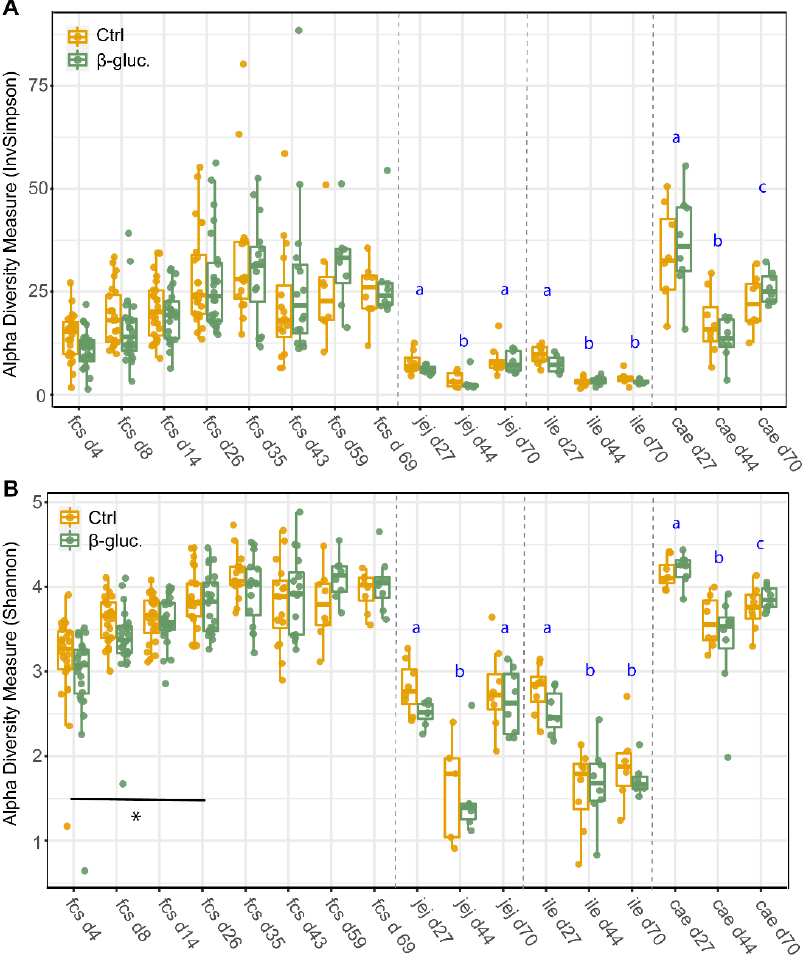
Figure 2. Alpha-diversity of faecal and luminal microbiota between treatments and over time. Every dot represents a single animal with the control animals in red and the β-glucan treated animals in green. InvSimpson diversity values ( A ) and Shannon diversity values ( B ) are given by sampling time point (d4-70) and by faeces (fcs) or gut segment; jejunum (jej), ileum (ile), caecum (cae). Letters (a, b, c) represent significant differences ( p < 0.05) between time points. The horizontal line with the corresponding asterisk represents the significant difference between treatment groups in the pre-weaning period, calculated using a Linear Mixed-E ff ects Model (*; p <